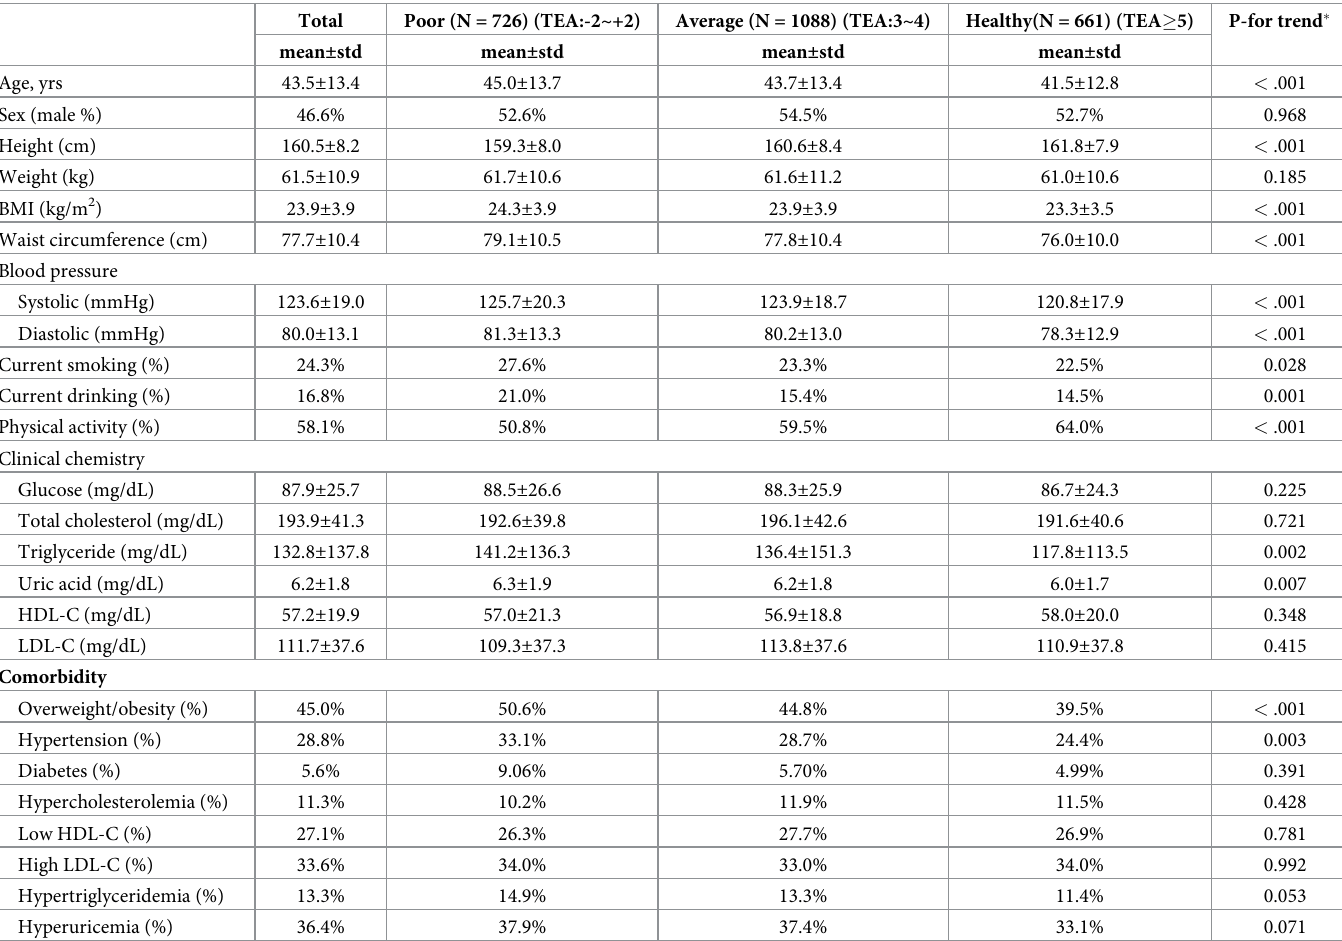
� : The trend associations of age and comorbidities for diet groups based on the Taiwanese Eating Approach (TEA) score was evaluated by general linear regression with ordinal TEA as an independent